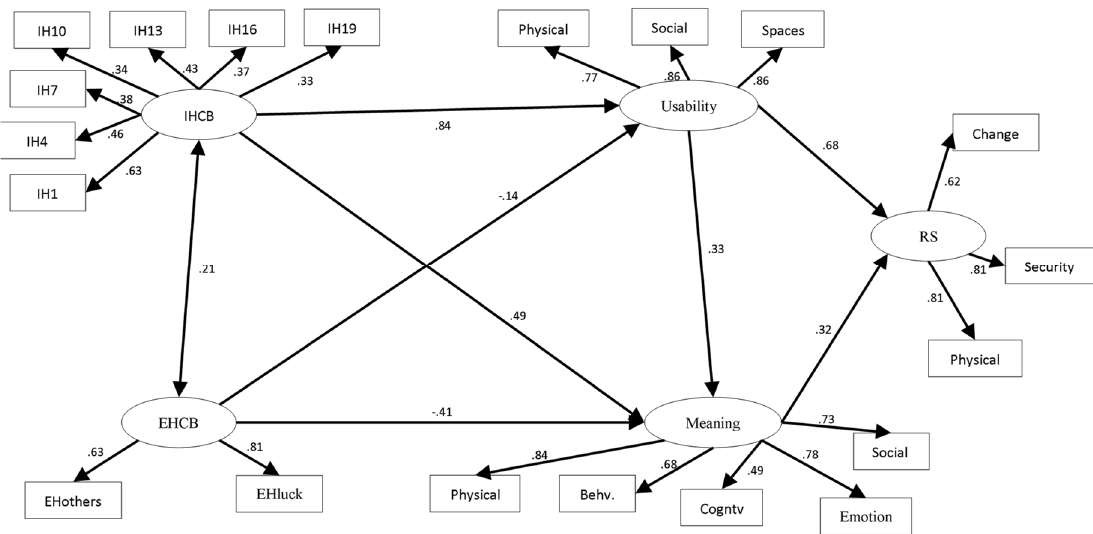
Figure 1. Structural equation model of internal housing-related control beliefs (IHCB), external housing-related control beliefs (EHCB), usability (Usability), meaning of home (Meaning) and housing options satisfaction (RS). Table 5. Structural effect parameters.